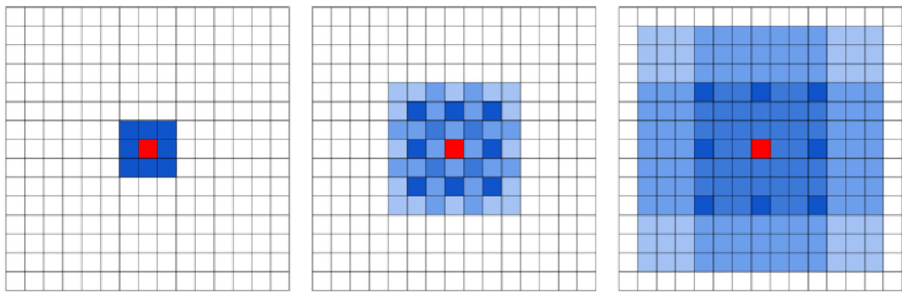
Fig 6. Covering effect of hybrid atrous convolution with unequal atrous rate.